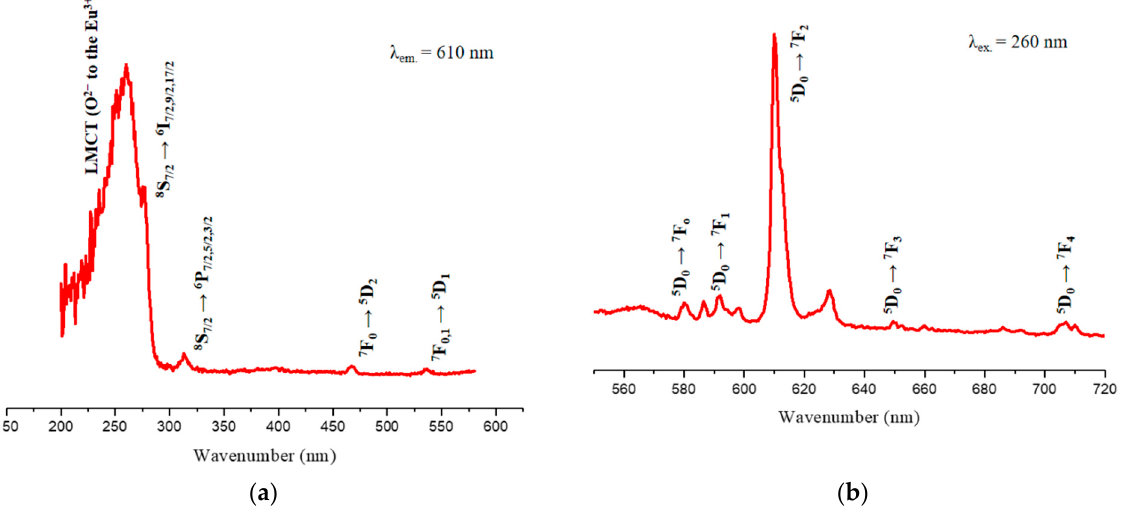
Figure 12. Excitation ( a ) and emission ( b ) spectra of the Gd 2 O 3 :Eu 3+ nanoparticles, representing the different electronic transitions that occur in this material.